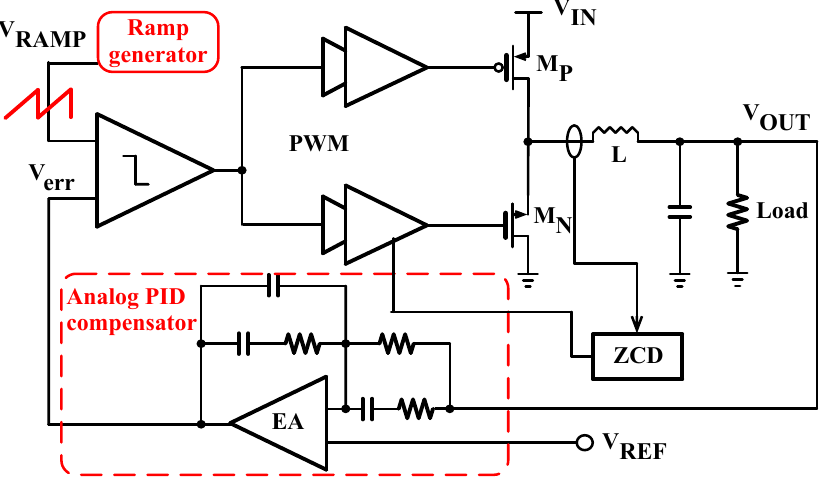
Figure 1. Structure of a DC–DC converter with the analog pulse width modulator